Question: What does this figure show? Answer in one sentence.
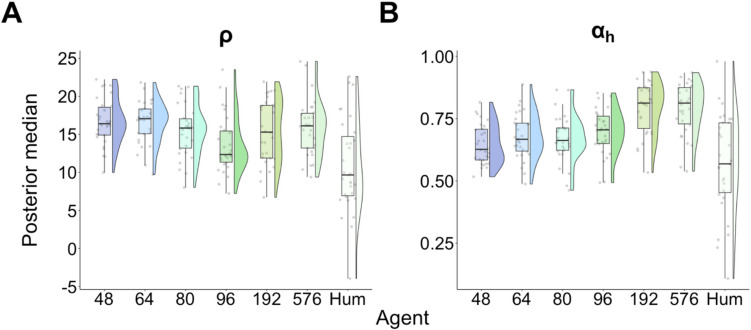
Answer: Perseveration behavior. X-axes represent networks grouped by capacity, defined by the no. of hidden units (48–576), along with human learners (Hum). ( A ) \documentclass[12pt]{minimal} \usepackage{amsmath} \usepackage{wasysym} \usepackage{amsfonts} \usepackage{amssymb} \usepackage{amsbsy} \usepackage{mathrsfs} \usepackage{upgreek} \setlength{\oddsidemargin}{-69pt} \begin{document}$$\uprho$$\end{document} ρ : Perseveration bonus. ( B ) \documentclass[12pt]{minimal} \usepackage{amsmath} \usepackage{wasysym} \usepackage{amsfonts} \usepackage{amssymb} \usepackage{amsbsy} \usepackage{mathrsfs} \usepackage{upgreek} \setlength{\oddsidemargin}{-69pt} \begin{document}$${\alpha }_{h}$$\end{document} α h : Habit step-size parameter. RNN data was aggregated across runs to obtain a single value for each network instance (mean)